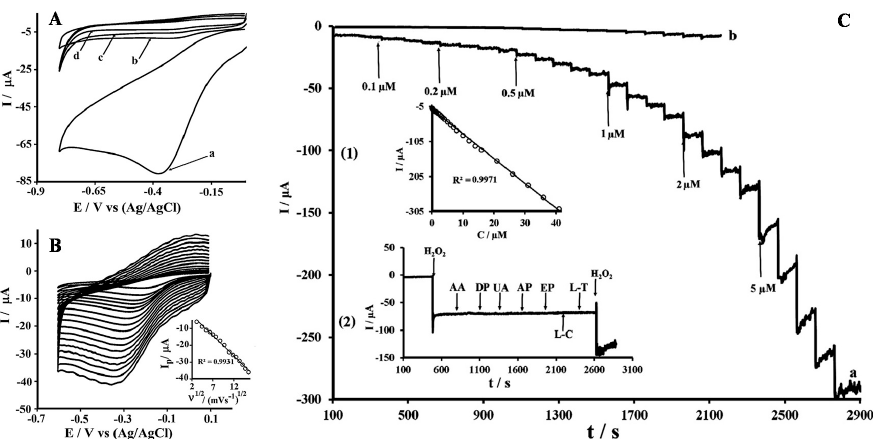
Figure 7. ( A ) Cyclic voltammograms (CV) of (a) glassy carbon electrode (GCE) modified with